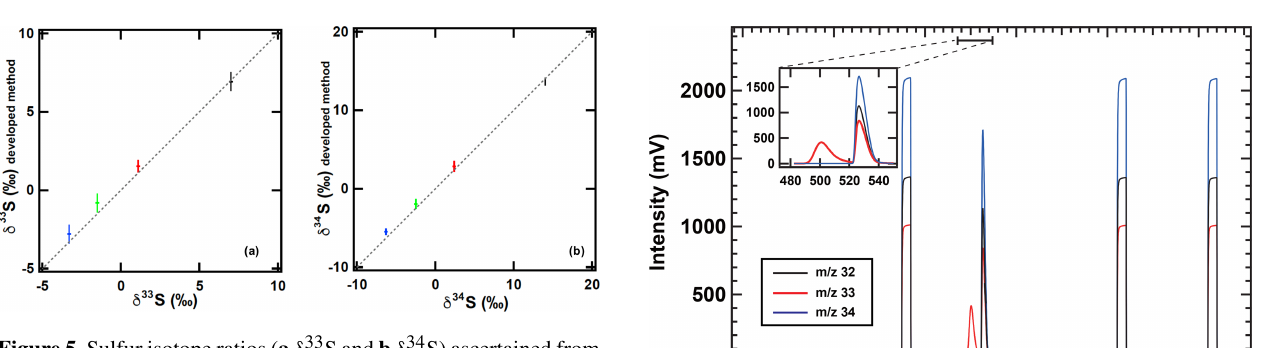
Figure 5. Sulfur isotope ratios ( a δ 33 S and b δ 34 S) ascertained from the developed sampling–purification system ( y axis) and conven- tional syringe injection system (Hattori et al., 2015) ( x axis). OCS sample amounts are 8nmol. Different colours represent different samples: black, sample B; red, sample C; green, sample D; blue, sample E. The dotted line shows the slope x = y . The error bar is 1 σ of each amount of triplicated OCS injection.